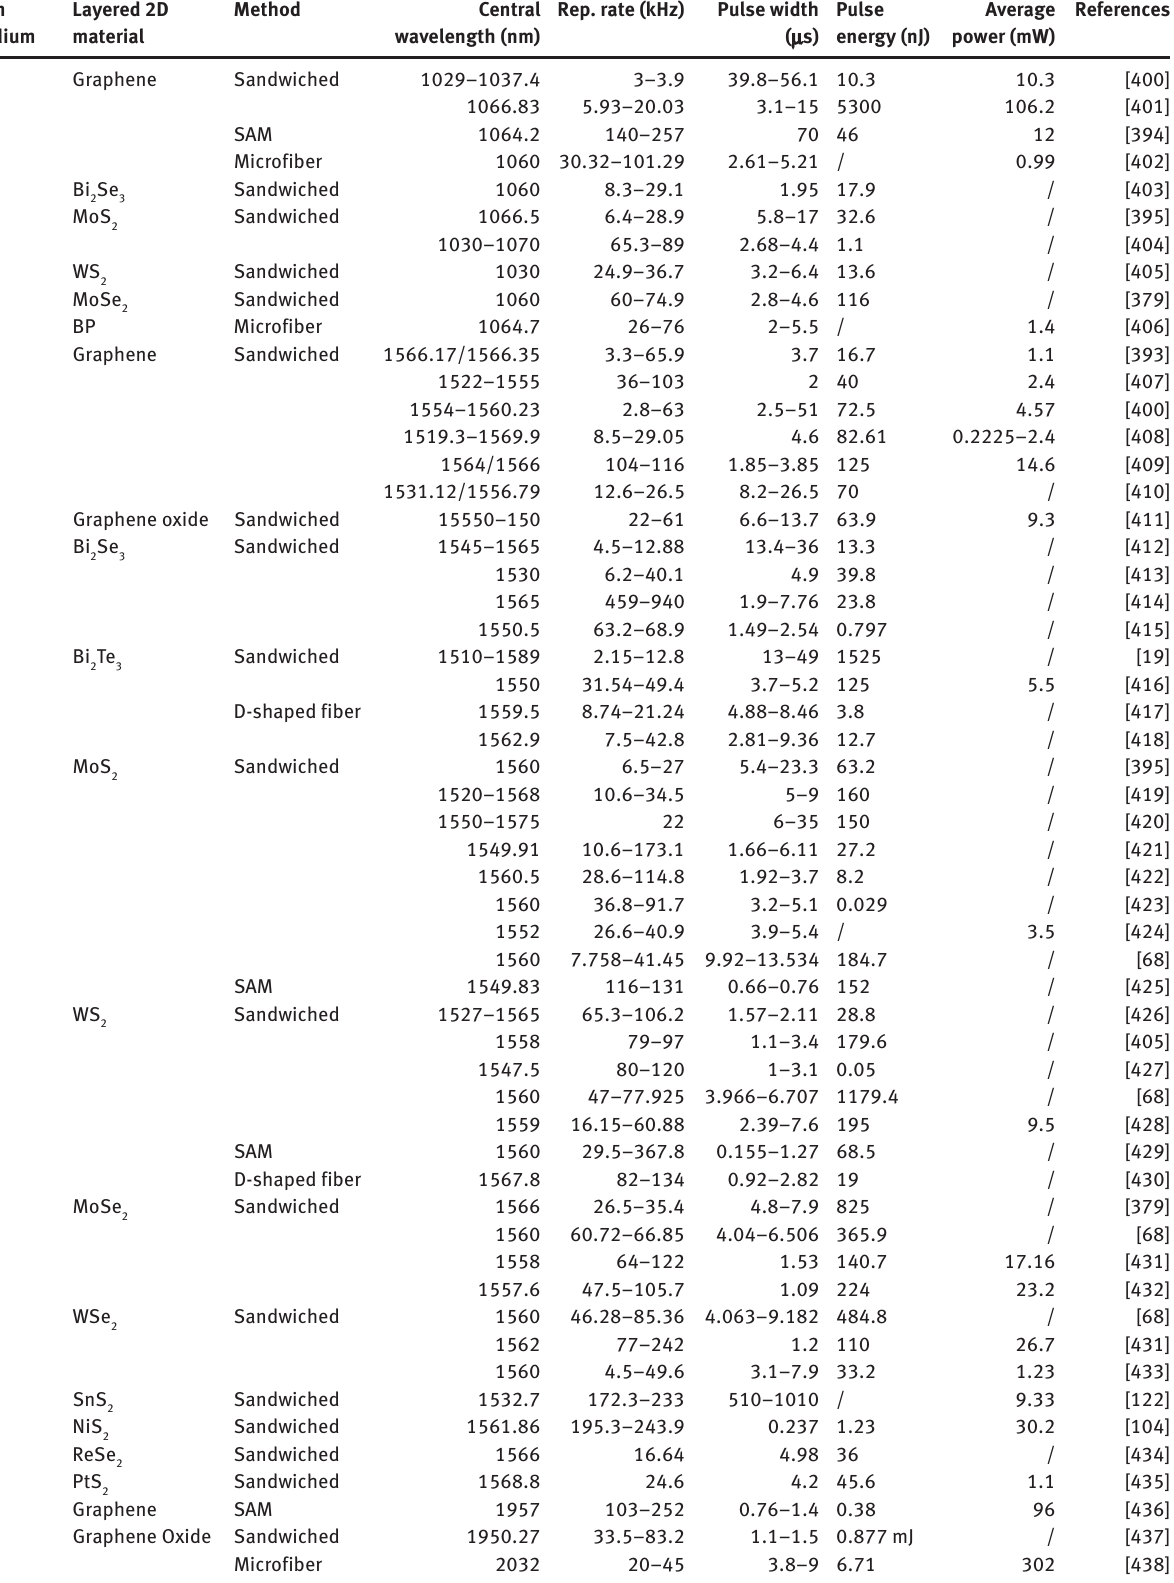
Table 5: Summary of Q-switched fiber lasers based on layered 2D materials.